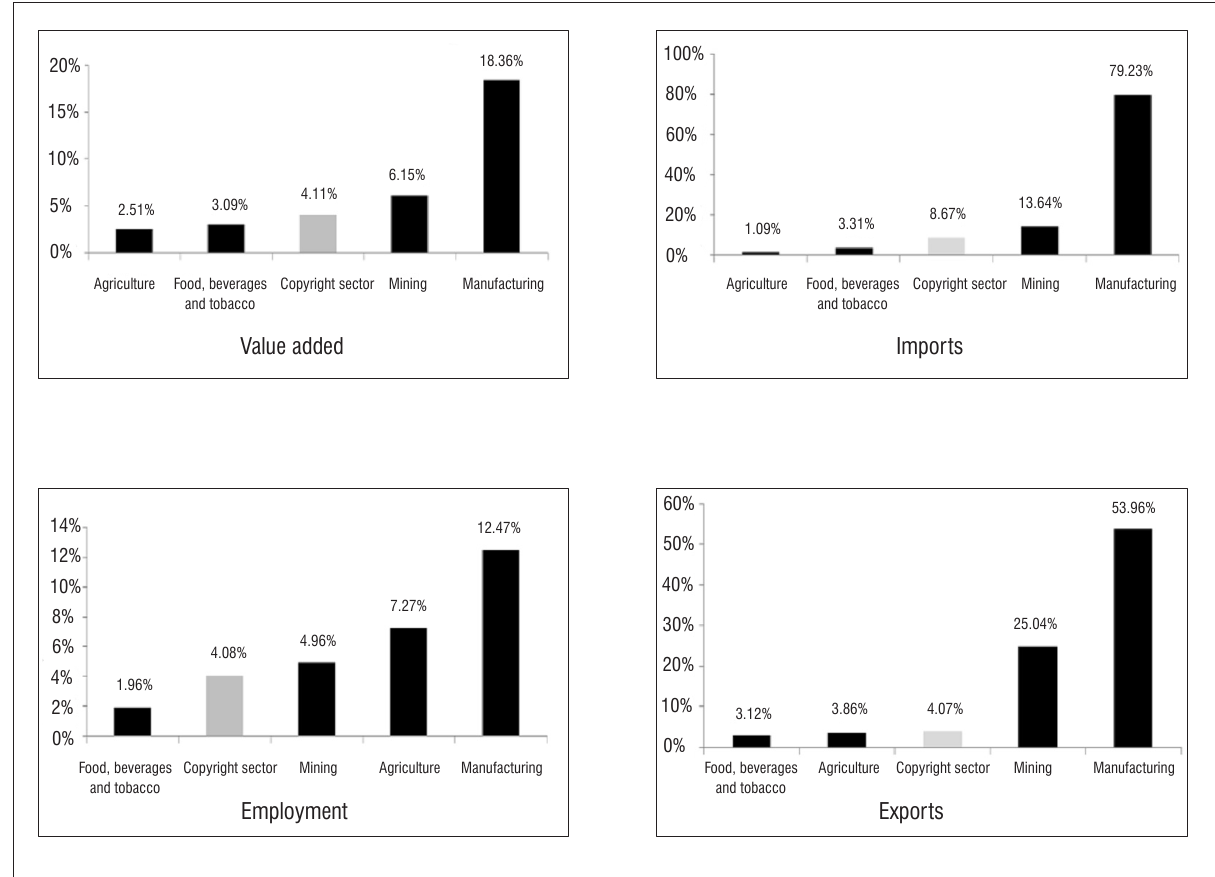
Figure 5: Comparison of the contribution to the economy of copyright-based industries with those of the main economic sectors in South Africa in